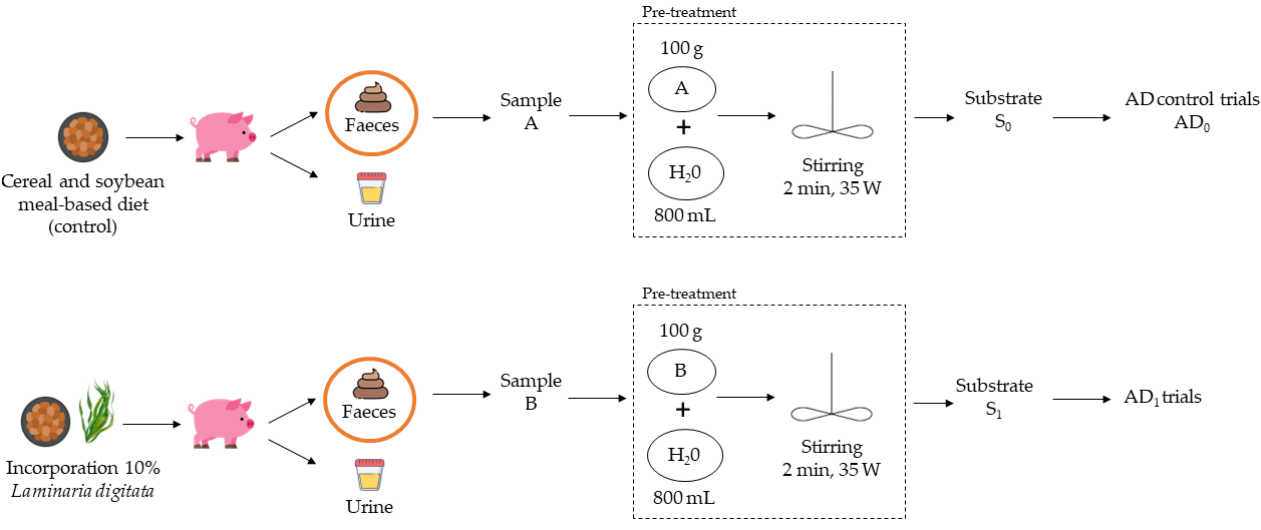
Figure 1. Substrate origins and pre-treatments for AD trials. Experimental conditions: mixing at 50 rpm, 35 W, for 2 min at room temperature.